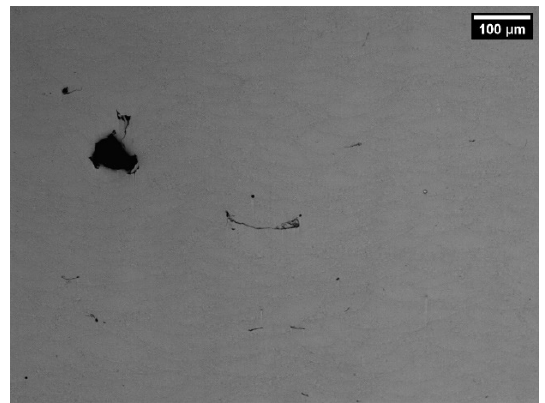
Figure 11. Cross-section morphology of sample built with P = 85 W, v = 650 mm/s and hd = 70 μ m .